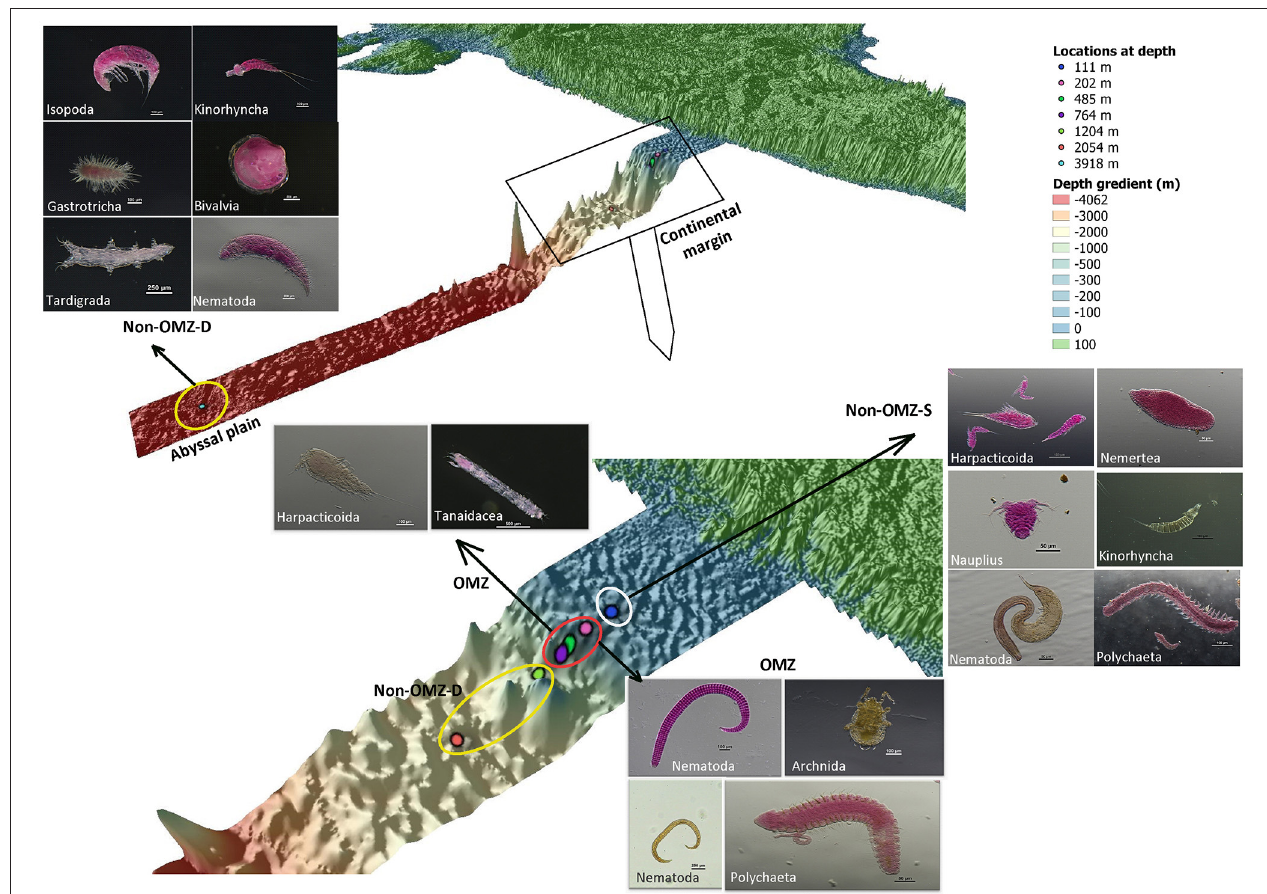
FIGURE 6 | The schematic representation of the distribution of meiofaunal taxa along the depth gradient of WICM and abyssal plain. The stations encircled with colors denotes a particular geomorphological character as White: non-OMZ-S, Red: OMZ and Yellow: non-OMZ-D.